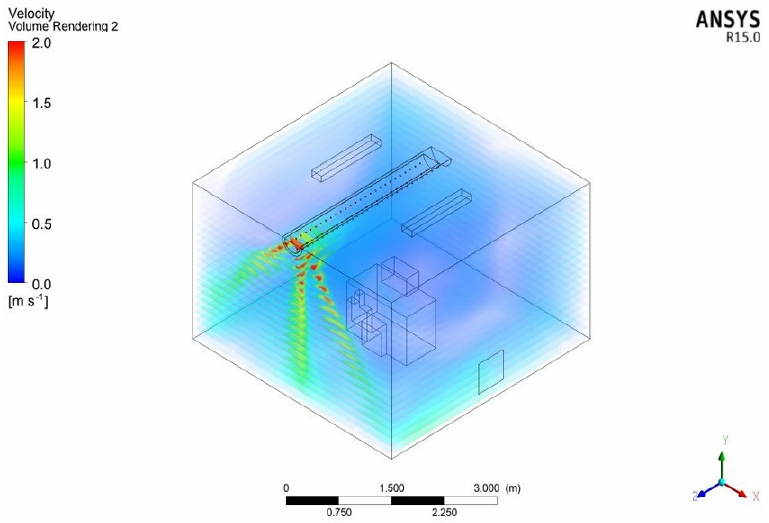
Figure 19. The schematic diagram of the air supply of the split-fiber distribution air conditioner at the bottom exhaust port.